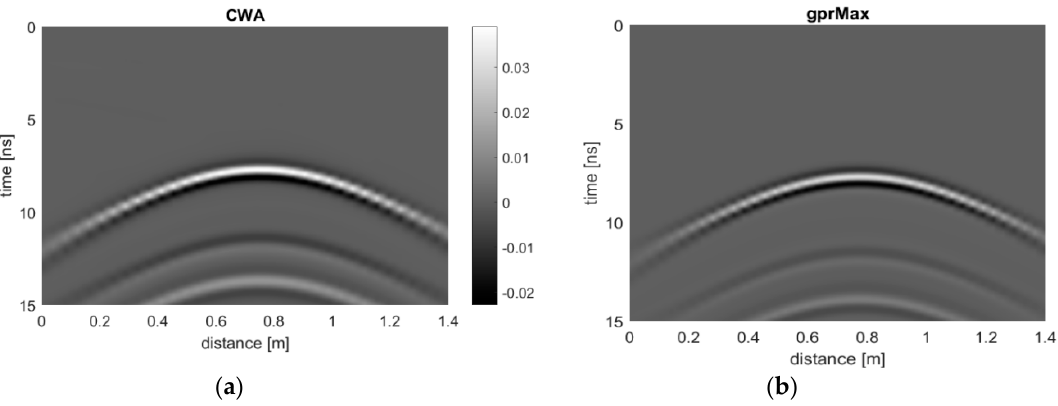
Figure 6. B-scan radargrams for a water target with permittivity modelled according to the Debye law in (34), with ε r 0 = 80, ε r ∞ = 4.9, and τ r = 9.3 × 10 − 12 s: ( a ) CWA; ( b ) FDTD simulation with